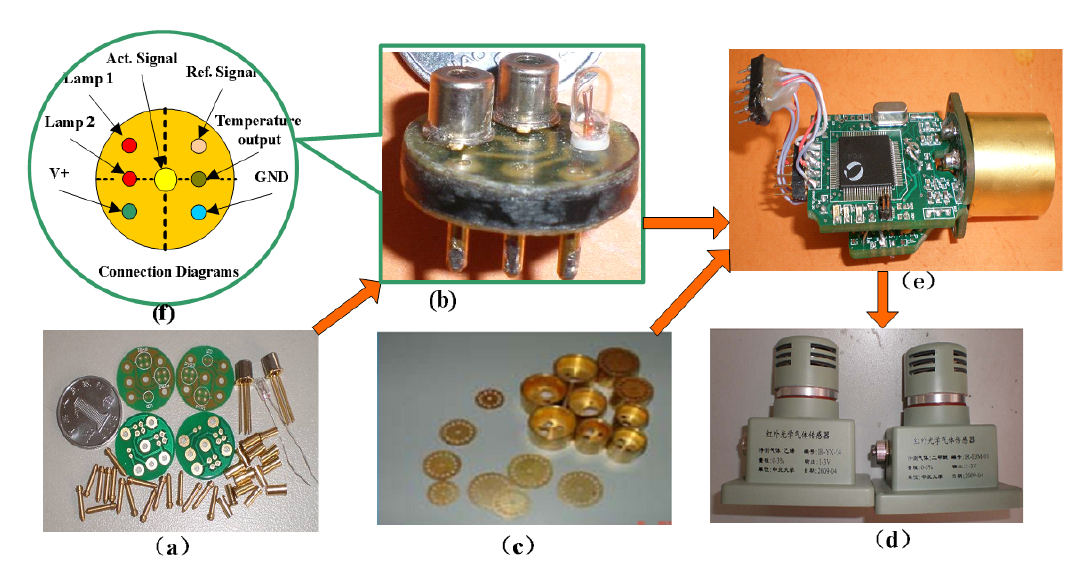
Figure 7. ( a ) Basic components of sensor; ( b ) integrated detector and light source; ( c ) miniature gilded air chamber; ( d ) peripheral IC of sensor; ( e ) end-product; and ( f )